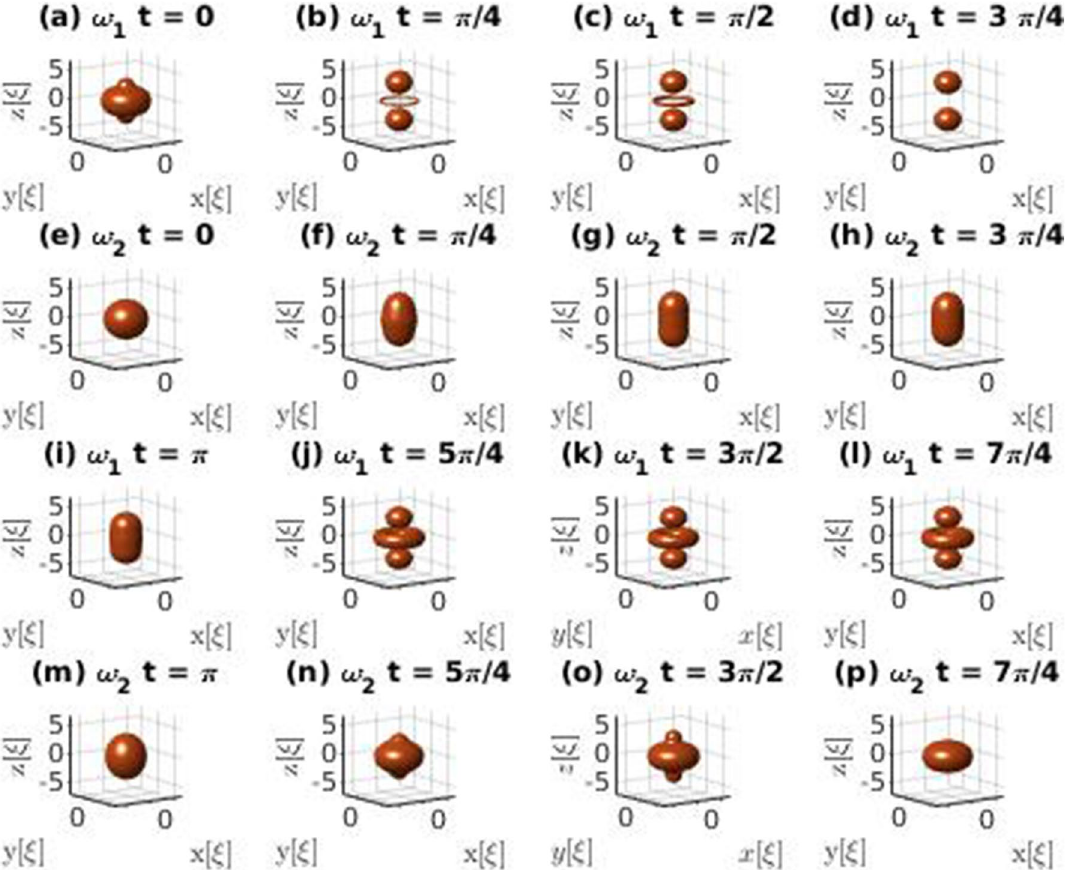
Figure 1. Comparative illustrations of the ideal evolution of the density of a quantum droplet formed by N ( Rb ) = 96818 and N ( K ) = 84578 atoms considering the excited quadrupole state, ℓ = 2 and m ℓ = 0 , generated from the ground state droplet. Ansatz 1 corresponds to rows ( a – d ) and ( i – l ) and ansatz 2 to rows ( e – h ) and ( m – p ). In this case ω 1 = 0.21 τ − 1 and ω 2 = 0.22 τ − 1 . The 3D graphs where generated by plotting isodensity surfaces at fifteen percent of the maximum density at each